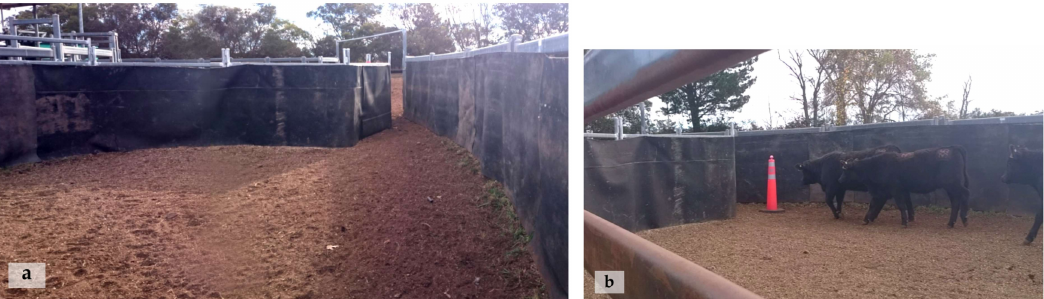
Figure 2. Photographs of the acclimation rate testing set up. Panel ( a ) shows the funnel structure without any obstacle present. Photograph was taken from inside the testing yard looking through to the feeding yard; Panel ( b ) shows the funnel structure on day 4 of testing with the traffic cone in place. This image was taken from a video recording during